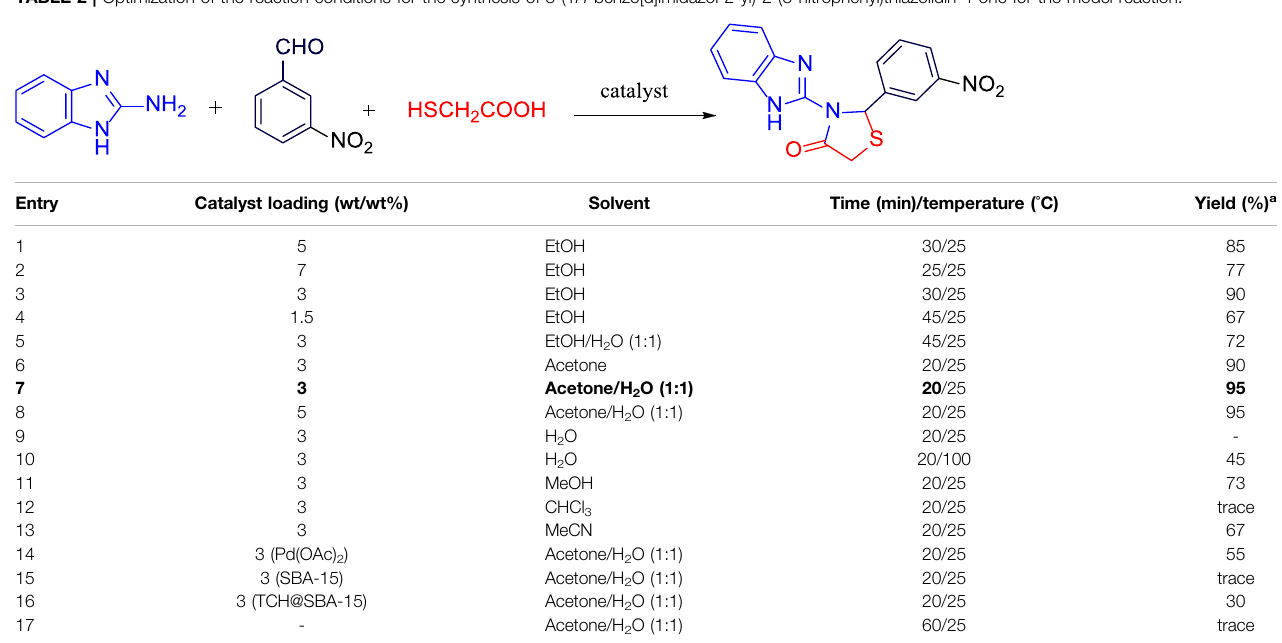
TABLE 2 | Optimization of the reaction conditions for the synthesis of 3-(1 H -benzo[d]imidazol-2-yl)-2-(3-nitrophenyl)thiazolidin-4-one for the model reaction.